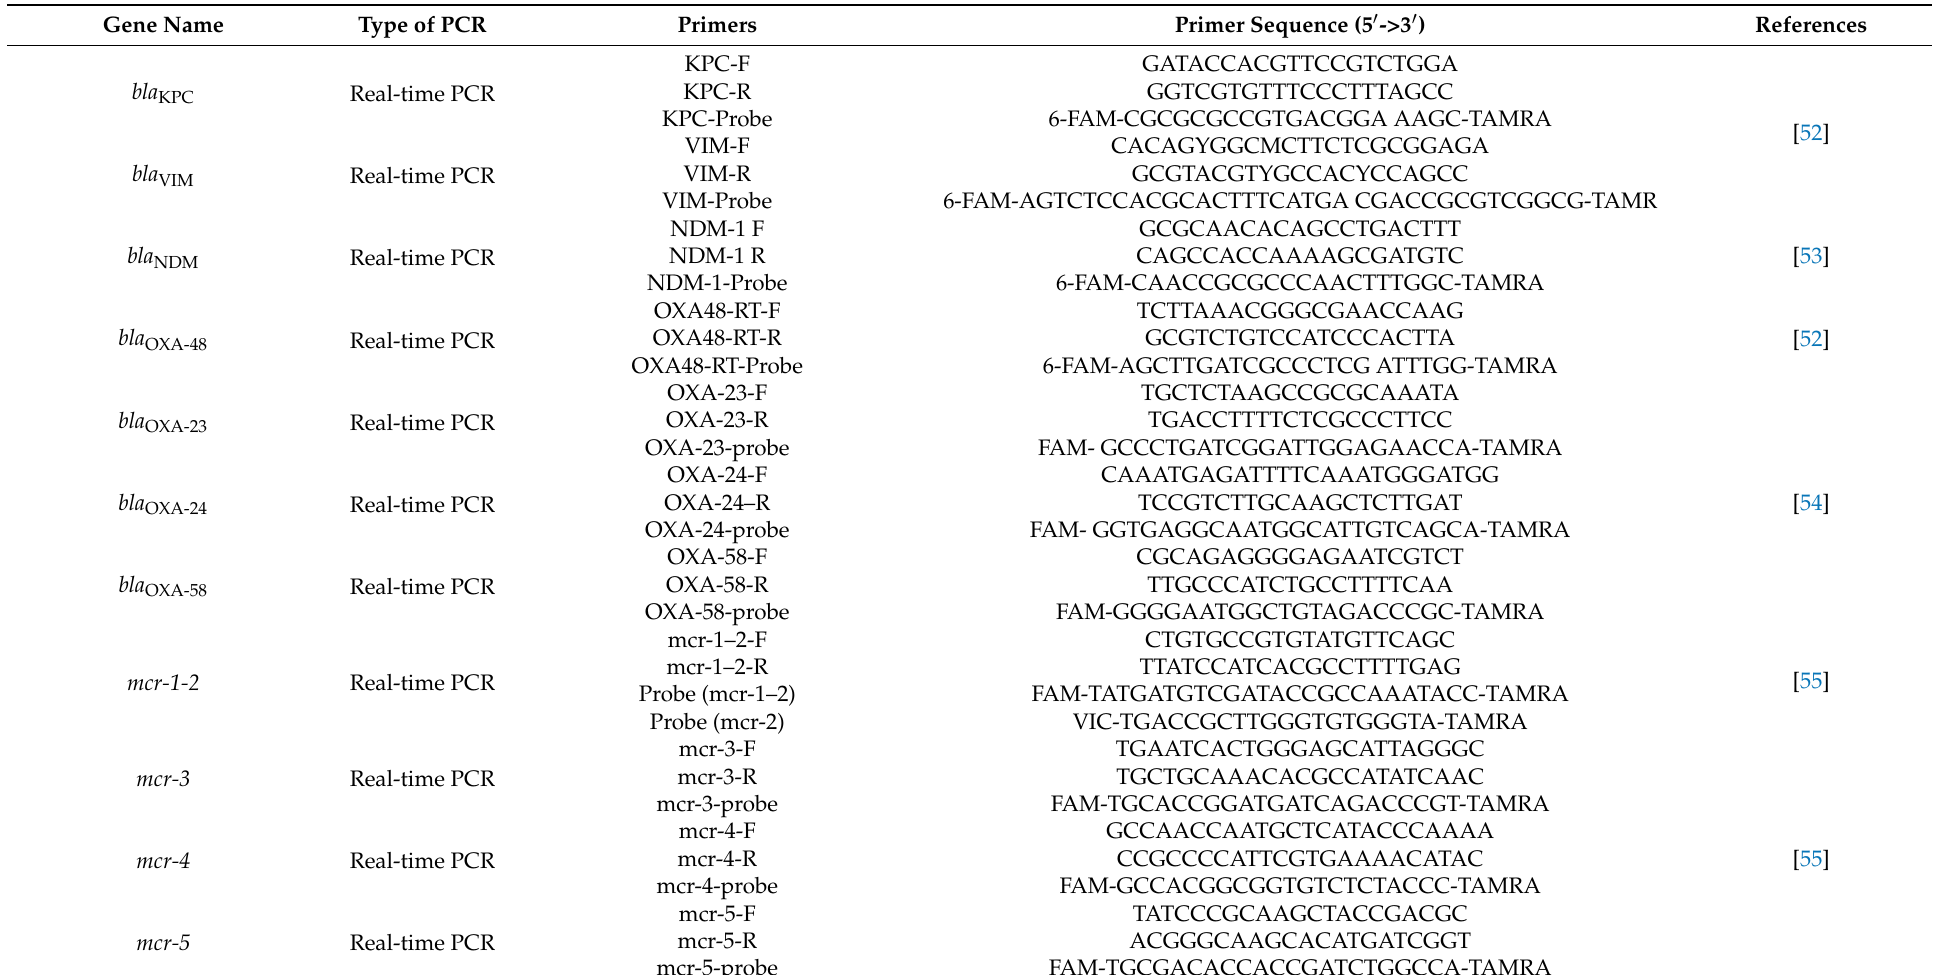
Table 2. Oligonucleotide primers and probes used for polymerase chain